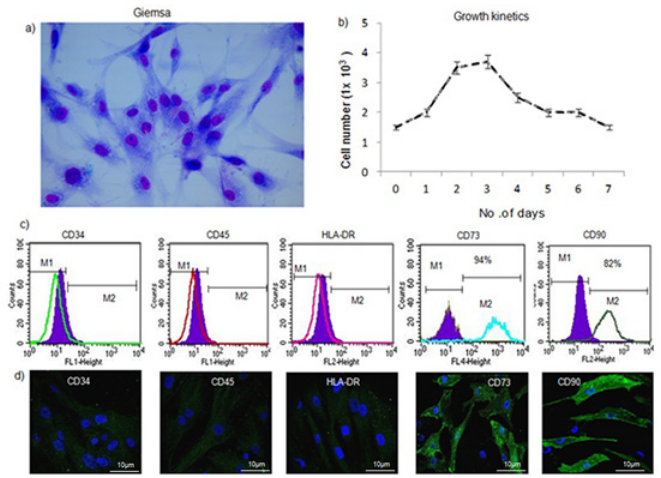
number increased to 4x10 3 cells/mL after 3 days. The decline phase started after 4 days and cell number was decreased to 1.3x10 3 cells/mL. c) Characterization of the following cell surface markers for hADSCs (n = 6) by flow cytometry: CD34-PE, CD45-FITC, HLADR-PE, CD90-FITC, and CD73-APC. The filled in histograms represent unstained negative control cells. CD34/45 markers were not expressed (0.2% and 0.3%, respectively), while low levels of HLADR expression (1.2%) were observed. hADSCs were positive for expression of CD90 (82%) and CD73 (94%), indicating a stem cell immunophenotype.